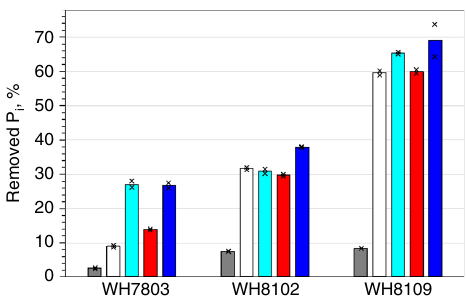
Fig. 7 Osmotic removal of the accumulated P i from the *P i pre-labelled cells. Comparison of removable *P i from live cells of the three Synechococcus strains incubated for 1 h and washed with arti fi cial seawater (grey bars), deionized water (white bars) and phosphate-buffered saline (turquoise bars) vs. PFA- fi xed cellular macromolecules (red bars) and TCA-precipitated nucleic acids (blue bars). The plot shows the results of a representative experiment. Bars present mean values of technical duplicates indicated as crosses. Horizontal grey lines indicate major ticks of the Y-axis to assist comparisons. Source data are provided as a Source Data fi